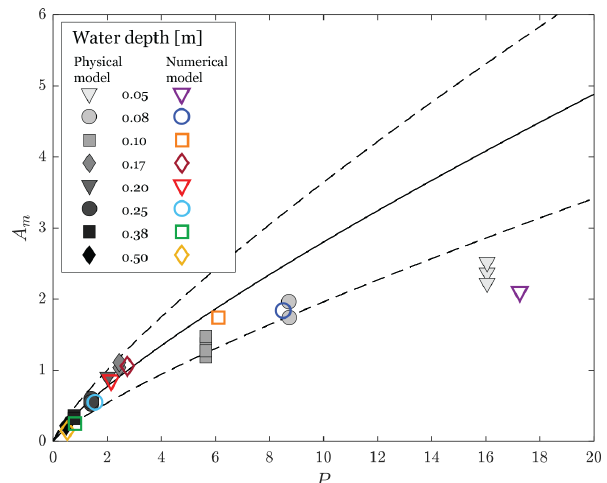
Figure 10. Maximum relative wave amplitude A m as a function of the impulse product parameter P : A M from Eq. (39) (solid line), A M from Eq. (39) ± 30% (dashed lines), data from the physical model (Miller et al., 2017) (solid shapes) and data from the numer- ical simulation (this study) (hollow